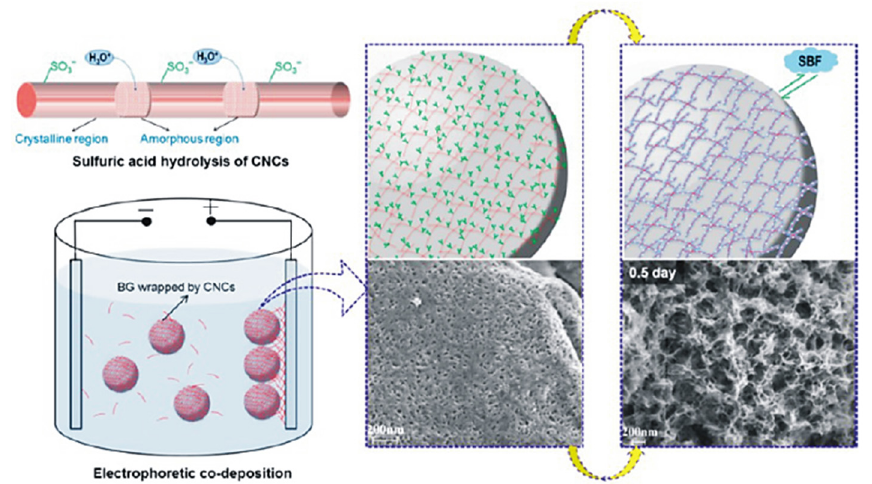
Figure 14. The schematic model describing the interaction between the BG particles and CNCs in the suspension, together with their electrophoretic co-deposition process as well as the mechanism of mineralization by the formation of HAp in the simulated body fluid. Reprinted with permission from [ 304 ] . Copyright 2015 American Chemical Society.